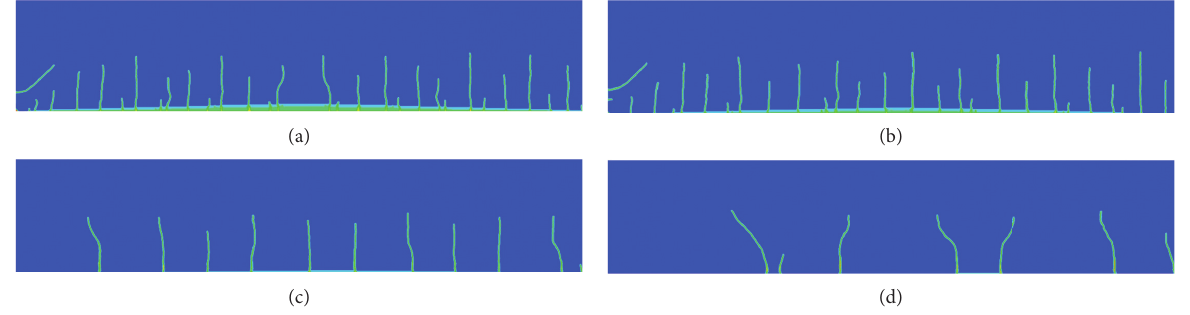
Figure 20: Thermal crack paths with a different ceramic fracture toughness ( t � 1.0 s): (a) K K IC- c � 4 MPa · m 1/2 ; (d) K IC- c � 5 MPa · m 1/2